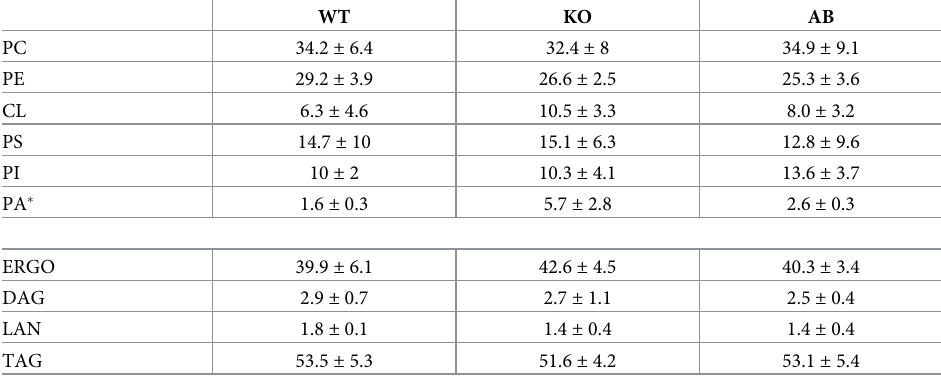
PC–phosphatidylcholine; PE–phosphatidylethanolamine; CL–cardiolipin; PS–phosphatidylserine; PI– phosphatidylinositol; PA—phosphatidic acid; ERGO–ergosterol; DAG–diacylglycerols; LAN–lanosterol; TAG– triacylglycerols. The asterisk denotes statistical significance P � 0.05.